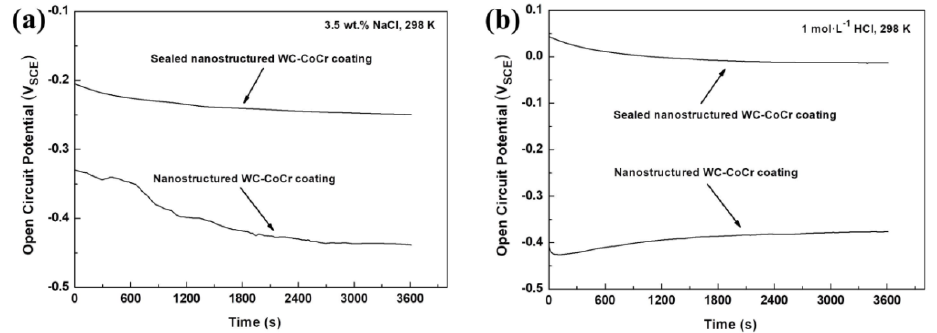
Figure 3. Open circuit potential (OCP) curves of unsealed and sealed nanostructured WC ‐ CoCr coatings in ( a ) 3.5 wt % NaCl and ( b ) 1 mol ∙ L − 1 HCl.